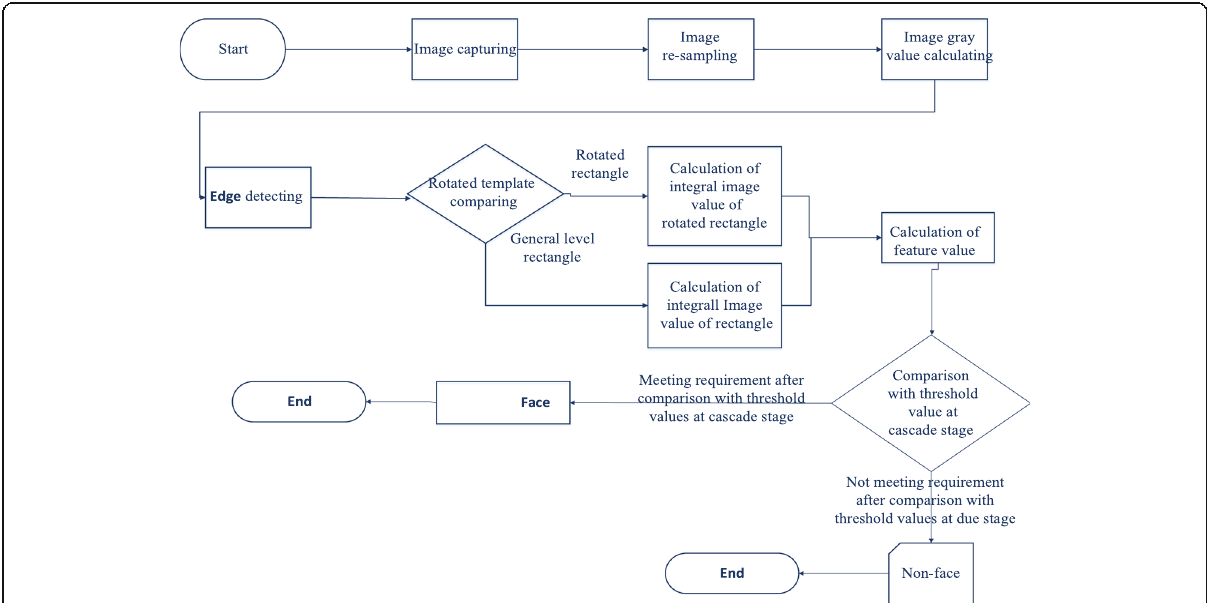
Fig. 13 Realization procedures of face detection based on HoloLens